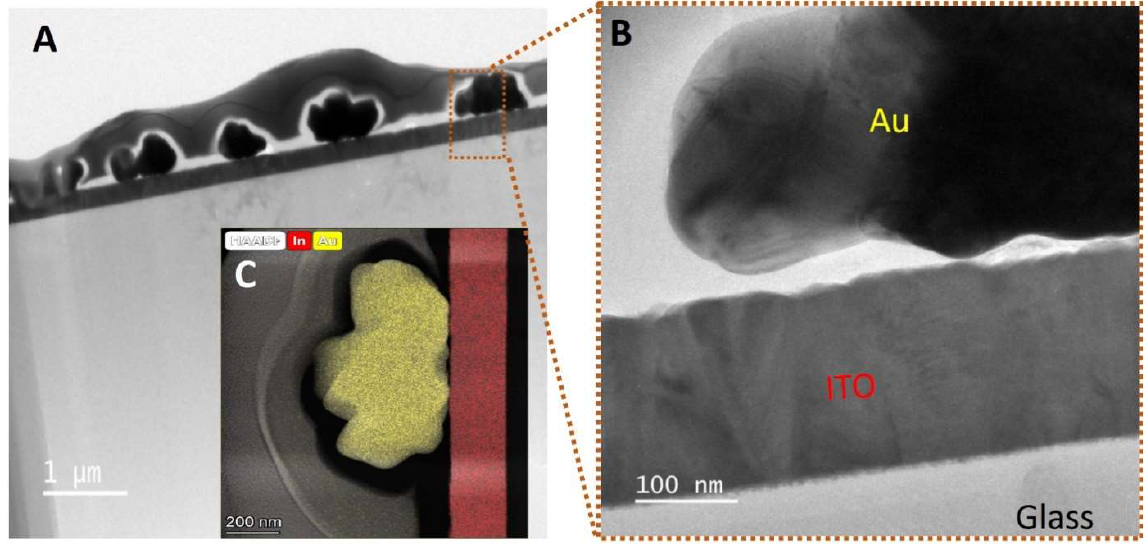
Figure 3. ( A ) TEM image of AuNPs, ( B ) magnified image of AuNPs and ( C ) TEM cross-section HAADF of AuNPs.